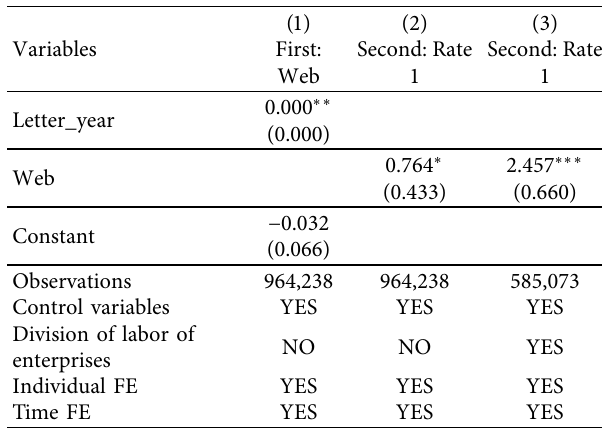
Table 7: Endogeneity test.